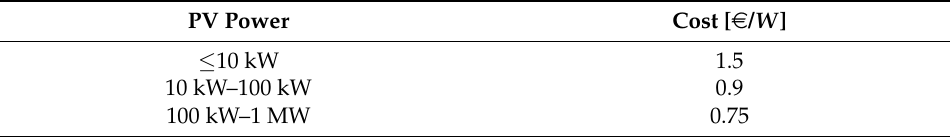
Table 1. Costs of PV installations.